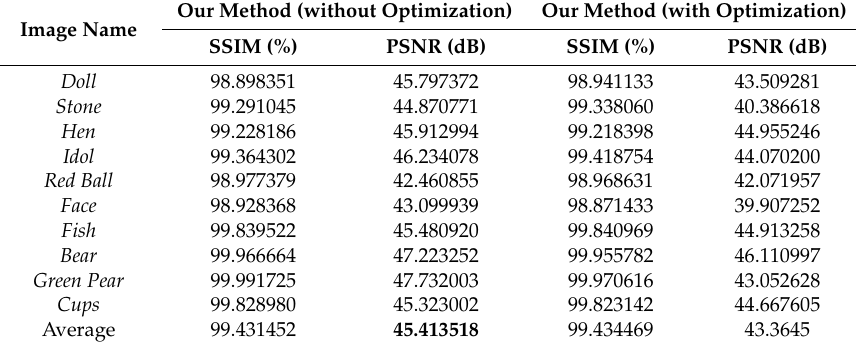
Figure 10. Visual comparison of Shen [22] and our method globally: ( ai – di ) input LDR images ( Stone , Ball , Bear , and Cups ); ( aii – dii ) HDR images using Shen’s [22] HF images; and ( aiii – diii ) HDR images by our proposed method. Table 8. Evaluation of hardware stage output.